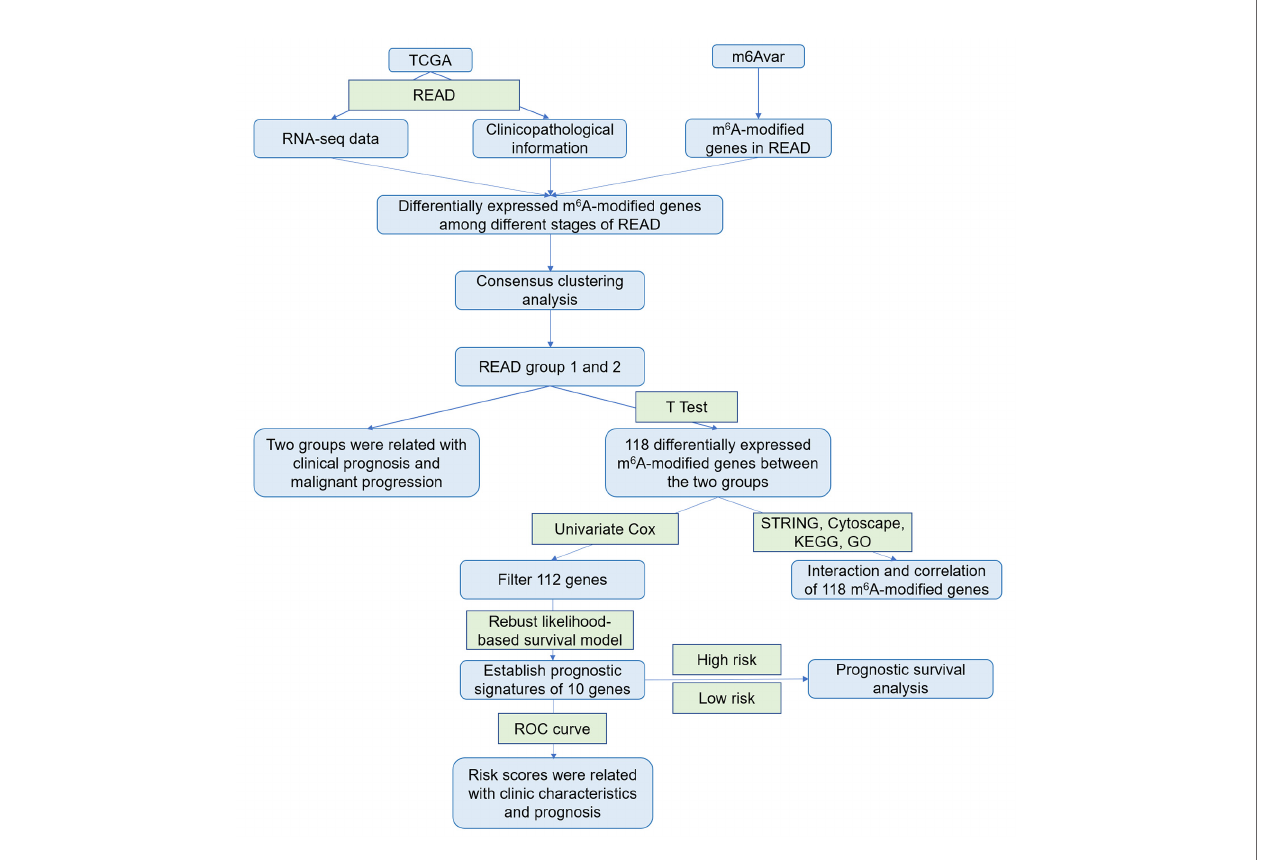
FIGURE 1 | The fl owchart of the